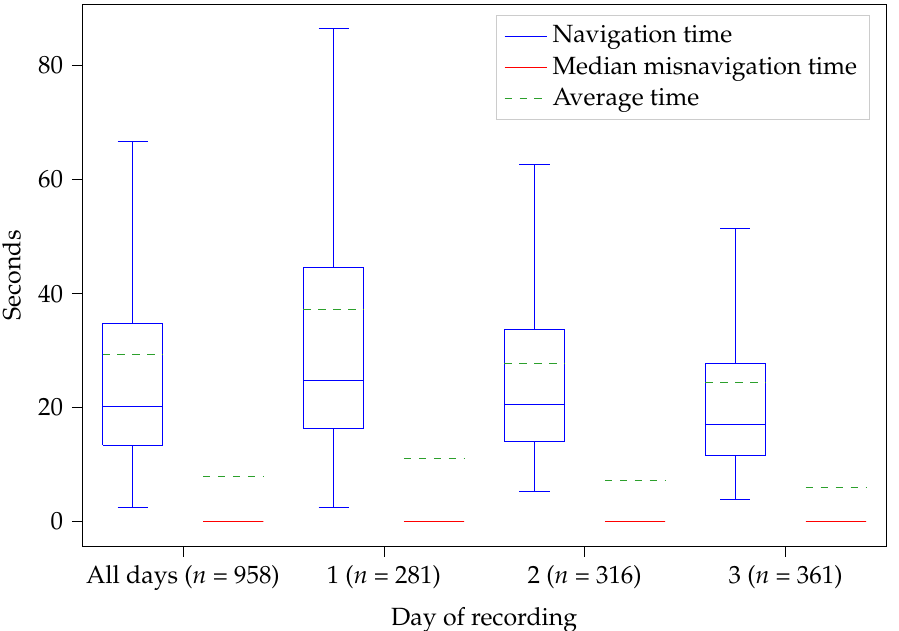
Figure 5. Comparison of the times needed by the participants of Study 2 to record a single FoBaST item. The mean time ( t mean ) and the mean misnavigation time ( t mis ) are 29.28s and 7.93s for all three days, 37.20 s and 11.14 s for the first day, 27.73 s and 7.25 s for the second day, and 24.49s and 6.03s for the third day. Note: The red lines—the median misnavigation times—are 0 because more than 50% of the corresponding paths have no misnavigation